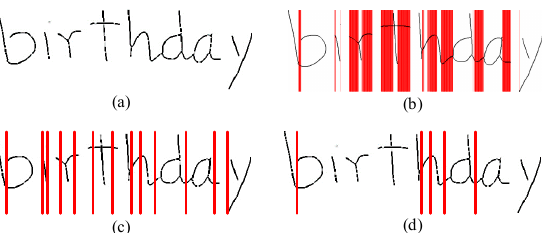
Figure 7. Segmentation based on vertical projection: ( a ) Original image, ( b ) image with segment lines after Step 1, ( c ) image with segment lines after Step 2, and ( d ) image with segment lines after Step 3.